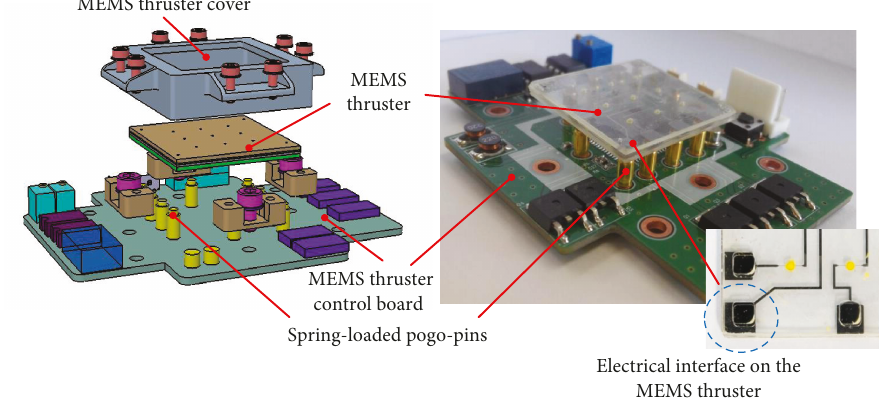
Figure 2: MEMS-based solid propellant thruster and its control board with spring-loaded pogo pin [22].